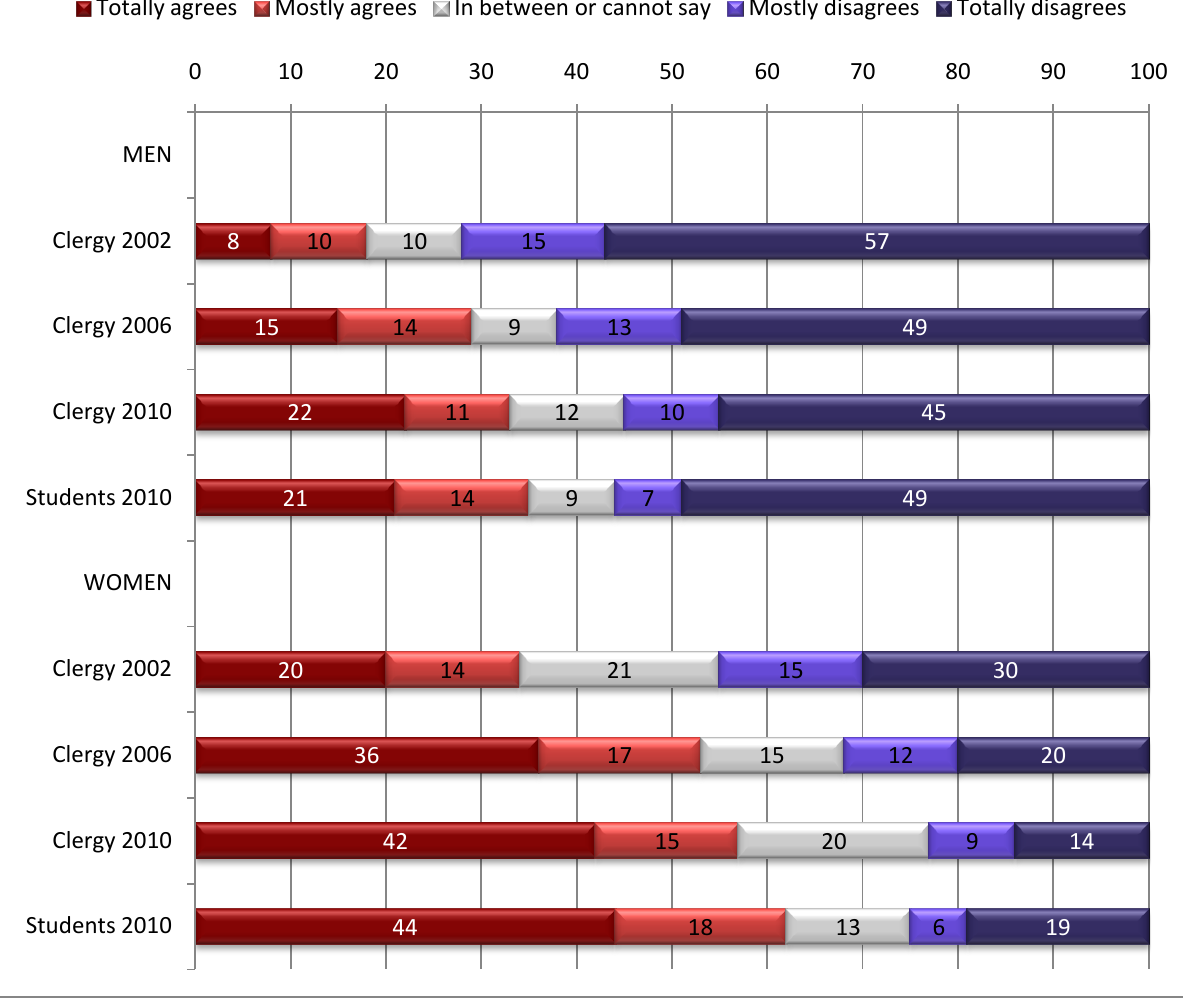
Figure 3. Should same-sex registered couples be granted a church blessing? Responses among male and female clergy in 2002 (N = 1,211), 2006 (N = 1,076), 2010 (N = 878) and among starting students of theology in 2010 (N =